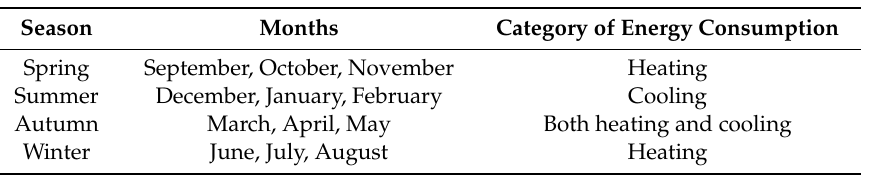
Table 5. Three categories of energy consumption over four seasons, months and the energy consumption category.